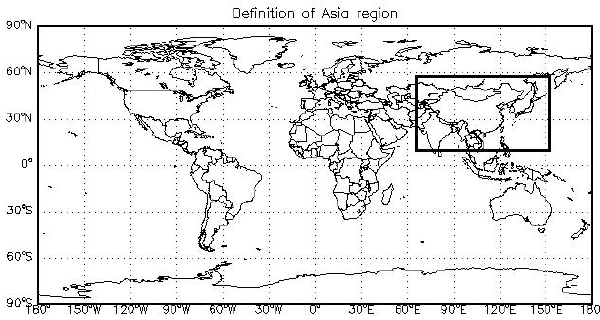
Fig. 1. Definition of Asia region for intercontinental transport study (longitude 63–150 ◦ E and latitude 10–58 ◦